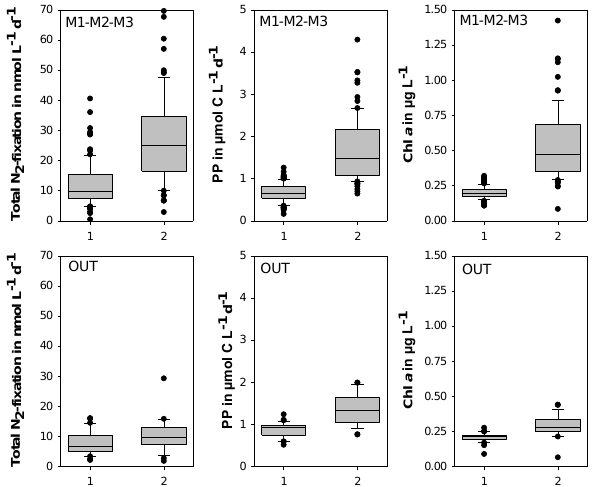
Figure 12. Box plots of primary production (in µmolCL − 1 d − 1 ) , N 2 -fixation rates (in nmolNL − 1 d − 1 ) and Chl a concentrations (in µgL − 1 ) in the three mesocosms (top panels) and in the lagoon wa- ters (bottom panels) during the two periods P1 and Figure 12 : Boxplots of primary production (in µmol C L -1 d -1 ), nitrogen-fixation rates (in nmol N L -1 d -1 ) and in Chl a concentrations (in µg L -1 ) in the three mesocosms (top pannels) and in the lagoon waters outside of mesocosms (bottom pannels) during the two periods P1 and P2.